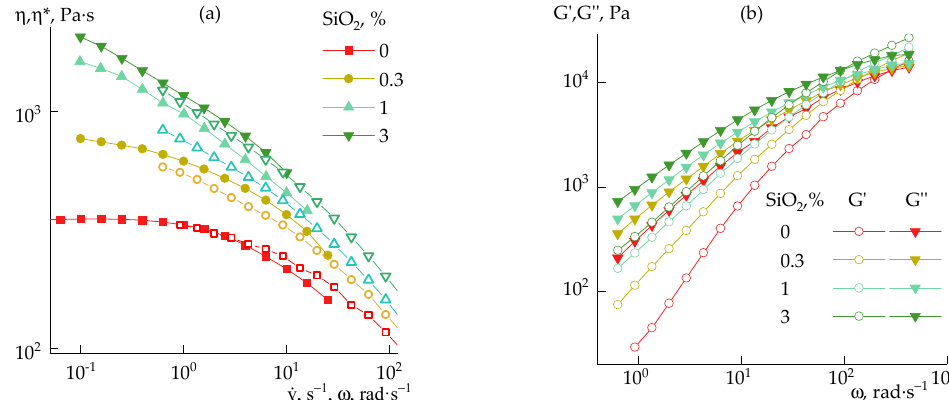
Figure 13. Flow curves measured with a stepwise increase in shear rate (shear viscosity is shown as open symbols and complex viscosity as filled symbols) ( a ) and frequency dependences of storage and loss moduli ( b ) of 33 wt% PAN solutions in DMSO with different silica content (at the solution weight indicated in graphs).